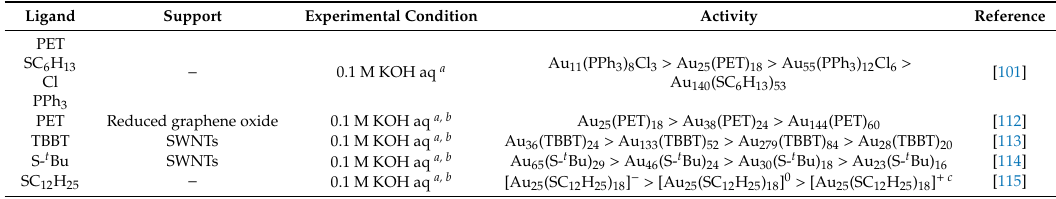
Figure 7. ( A ) Cyclic voltammograms of Au n (SR) m / GCE ( n = 11, 25, 55, and 140) saturated with O 2 and Figure 7. (A) Cyclic voltammograms of Au n (SR) m /GCE ( n = 11, 25, 55, and 140) saturated with O 2 and Au 11 (PPh 3 ) 8 Cl 3 / GCE saturated with N 2 (thin solid curve). ( B ) Current density and overpotential of Au 11 (PPh 3 ) 8 Cl 3 /GCE saturated with N 2 (thin solid curve). (B) Current density and overpotential of ORR activity with each size of Au n NCs. ( C )Koutecky–Levich plots at di ff erent applied potentials of a ORR activity with each size of Au n NCs. (C) Koutecky–Levich plots at different applied potentials of GCE modified with Au 11 (PPh 3 ) 8 Cl 3 . ( D ) Rotating-disk voltammograms (rotation rate: 3600rpm) of various Au n (SR) m / GCE ( n = 11, 25, 55, and 140). Panels ( A – D ) are reproduced with permission from a GCE modified with Au 11 (PPh 3 ) 8 Cl 3 . (D) Rotating-disk voltammograms (rotation rate: 3600 rpm) of various Au n (SR) m /GCE ( n = 11, 25, 55, and 140). Panels (A–D) are reproduced with permission from Table 3. Representative references on ORR activity of Au n